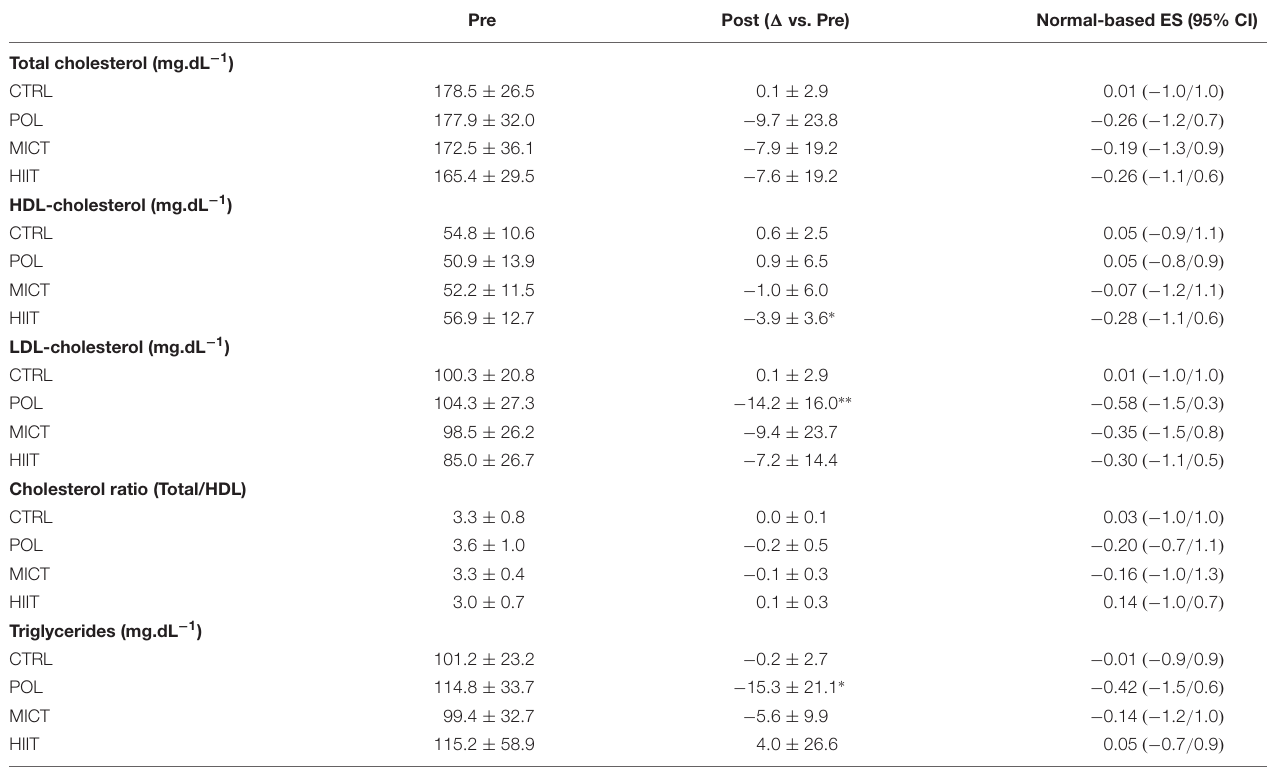
TABLE 2 | Changes in plasma lipids after 12-weeks of intervention. Pre Post ( (cid:49) vs. Pre) Normal-based ES (95% CI)